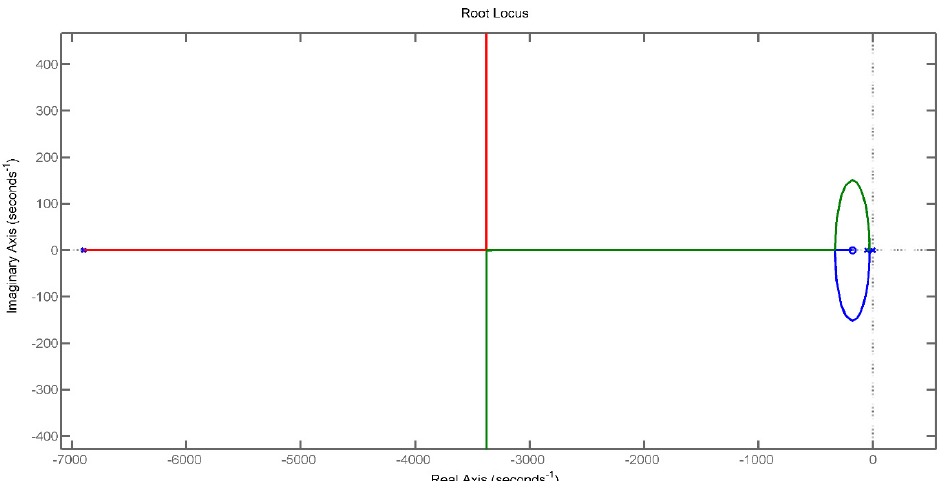
Figure 12. Root locus for the roll attitude-control with the designed controller.